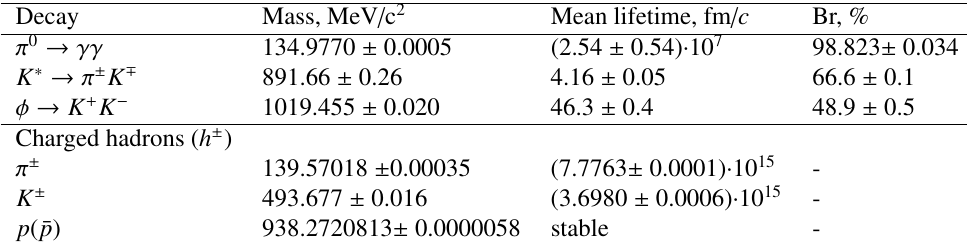
Table 1: Particle masses, decay channels, mean lifetimes and branching ratios